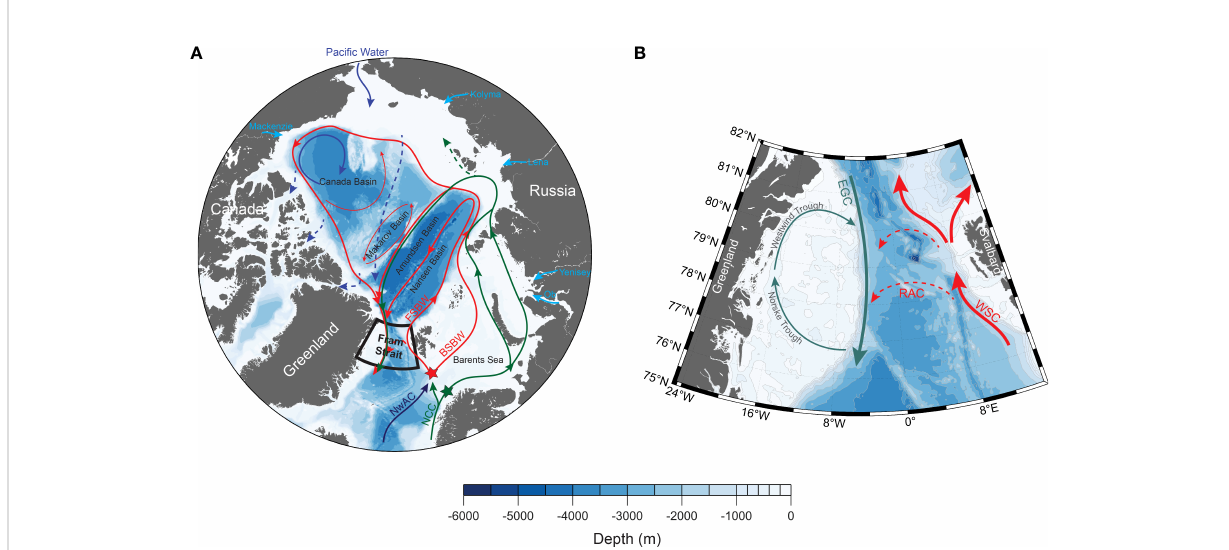
FIGURE 1 (A) Circulation of Atlantic (red and green) and Paci fi c (blue) waters in the Arctic Ocean. Green arrows depict the circulation of Atlantic Water originating from the Norwegian Coastal Current (NCC) in the surface layer. Red arrows depict the circulation of Fram Strait Branch Water (FSBW) and Barents Sea Branch Water (BSBW) in the mid-depth Atlantic layer. Star symbols show the locations where the surface (green star) and mid- depth Atlantic layer (red star) input functions of 129 I and 236 U to the Arctic Ocean, depicted in Figure 2, were de fi ned. Light blue arrows depict in fl ow of major rivers draining into the Arctic Ocean. The black outline highlights the Fram Strait study area shown in (B) . The map was modi fi ed after Figure 1 in We fi ng et al. (2021). NwAC: Norwegian Atlantic Current. (B) Map of Fram Strait with main circulation features in the upper water column including the West Spitsbergen Current (WSC), East Greenland Current (EGC), and Return Atlantic Current (RAC), as well as main topographic features on the Greenland